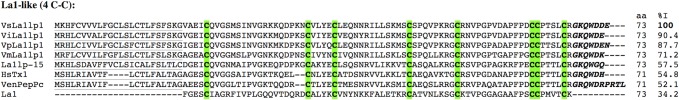
Sequence alignment of the La1-like peptides found in the Vaejovis libraries.The precursor sequences of VmLa1lp1 from V. mexicanus, VsLa1lp1 from V. subcristatus and VpLa1lp1 from V. punctatus are aligned to the previously reported precursors of La1lp-15 (UniProt:AGA82761) from U. yaschenkoi, HsTx1 (UniProt:K7WMX6) from H. spinifer, VenPepPc (UniProt:H2CYP1) from P. cavimanus, and the mature La1 (UniProt:P0C5F3) from L. australasiae. The peptide length (aa) always refers to the confirmed (when the peptide has been isolated from the venom) or software-predicted mature peptides. The given percentages of identity (%I) correspond to the mature peptides only, and are relative to the first sequence. The predicted signal peptides are shown underlined, the propeptides in italics and bold.